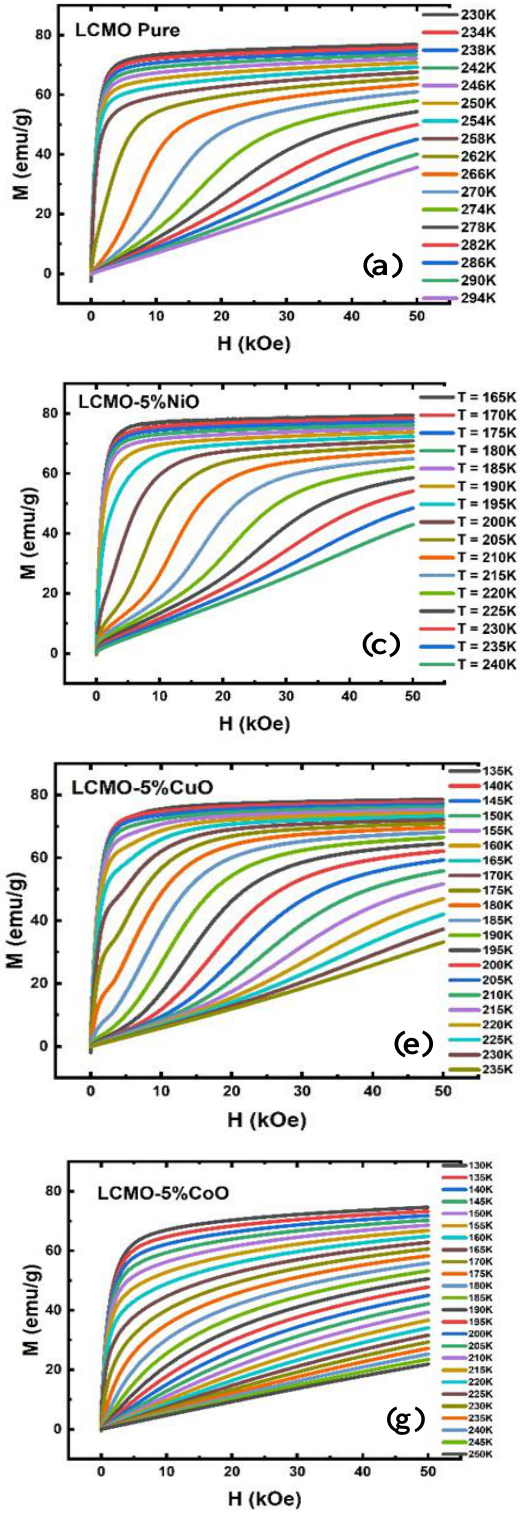
Figure 5. Isothermal magnetization curves for LCMO–MO composite samples ( a ) LCMO-pure, ( b ) LMCO- 2.5 % NiO, ( c ) LMCO- 5 % NiO, ( d ) LCMO- 2.5 % CuO, ( e ) LCMO- 5 % CuO, and ( f ) LCMO- 2.5 %CoO, ( g ) LCMO- 5